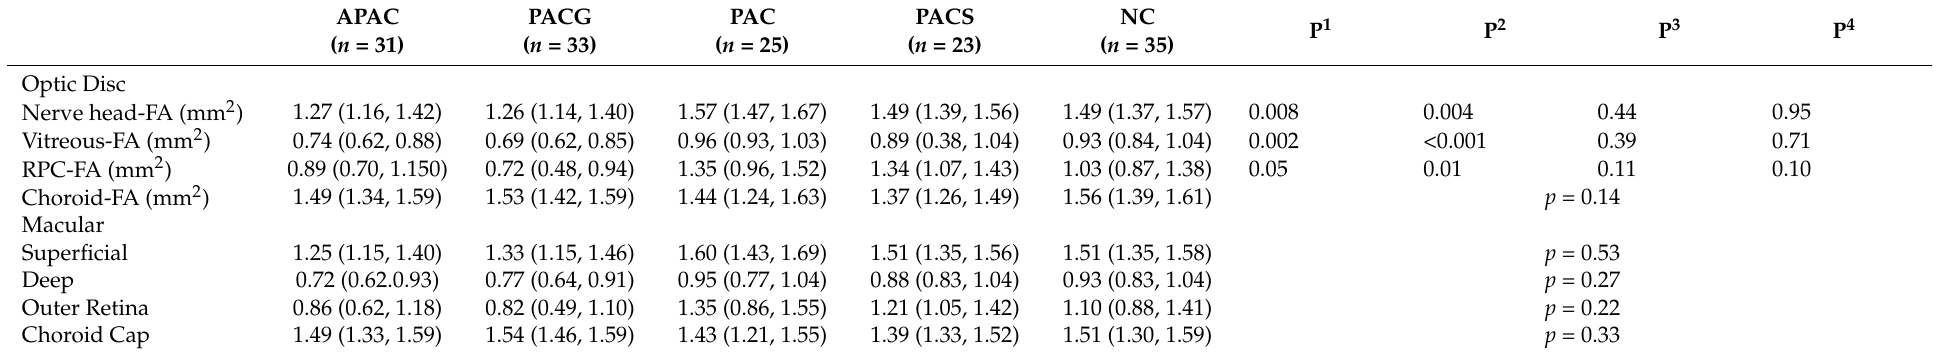
Table 3. The flow area (FA) of